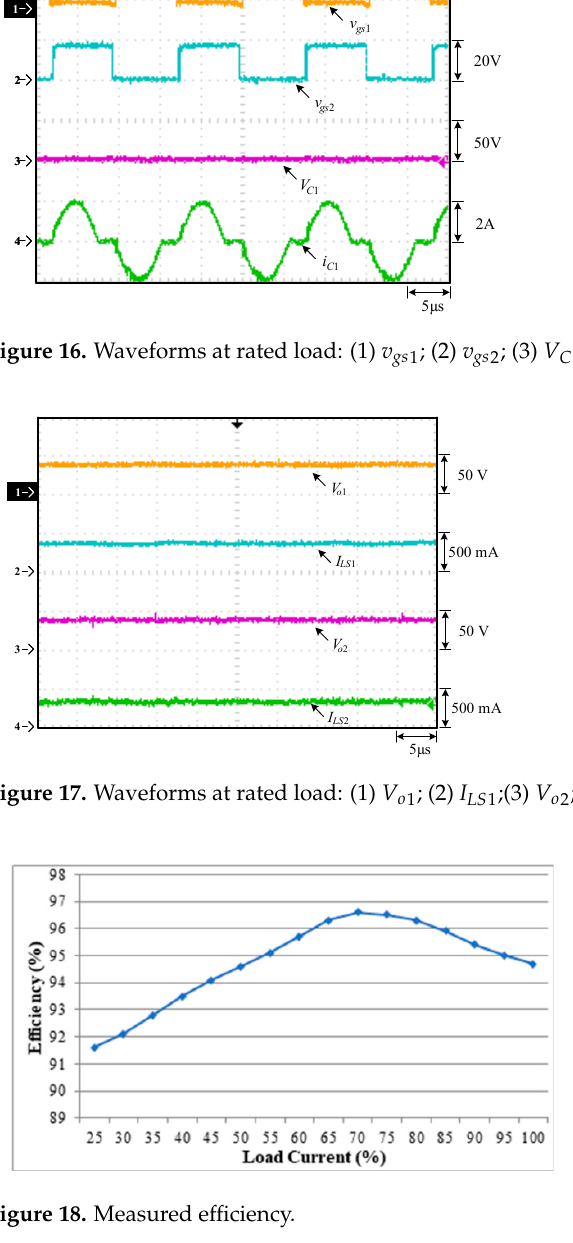
Figure 18. Measured efficiency. Figure 18. Measured